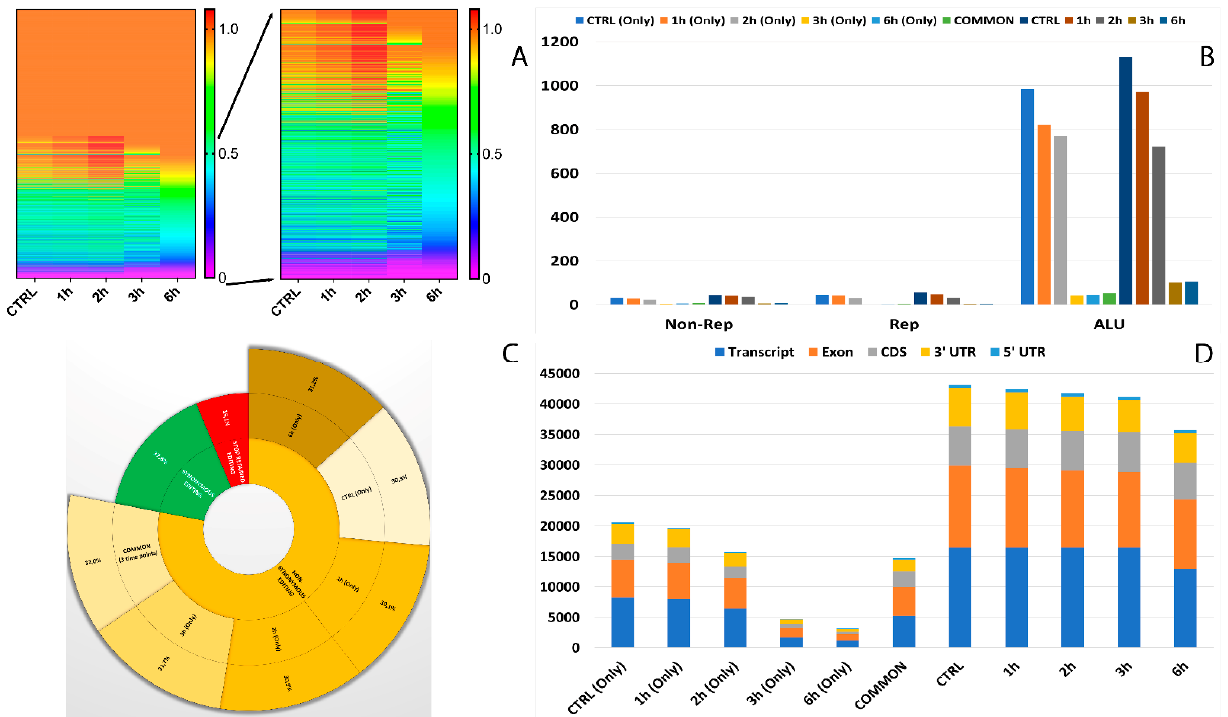
Figure 4. Editome known signatures during A2E exposure. ( A ) A heat map of the editing frequency from known sites that are particularly edited across A2E treatment. The color (from purple to red) indicates the editing frequency (from 0 to 1) for a given site (row) in a specific time point (column). The sub-heat map on the right underlines only the sites which changed during the treatment. ( B ) The proportion of known editing sites within ALU sequences, other repetitive elements, and outside SINEs across different time points. ( C ) The proportion of the non-synonymous shift in coding region affected by known editing sites. ( D ) The distribution of known editing sites across different genomic elements. Syn. = Synonymous. Non-Syn. = Non-Synonymous. Stop Ret. = Stop Retained. Comm. = Common. TPs = Time Points.